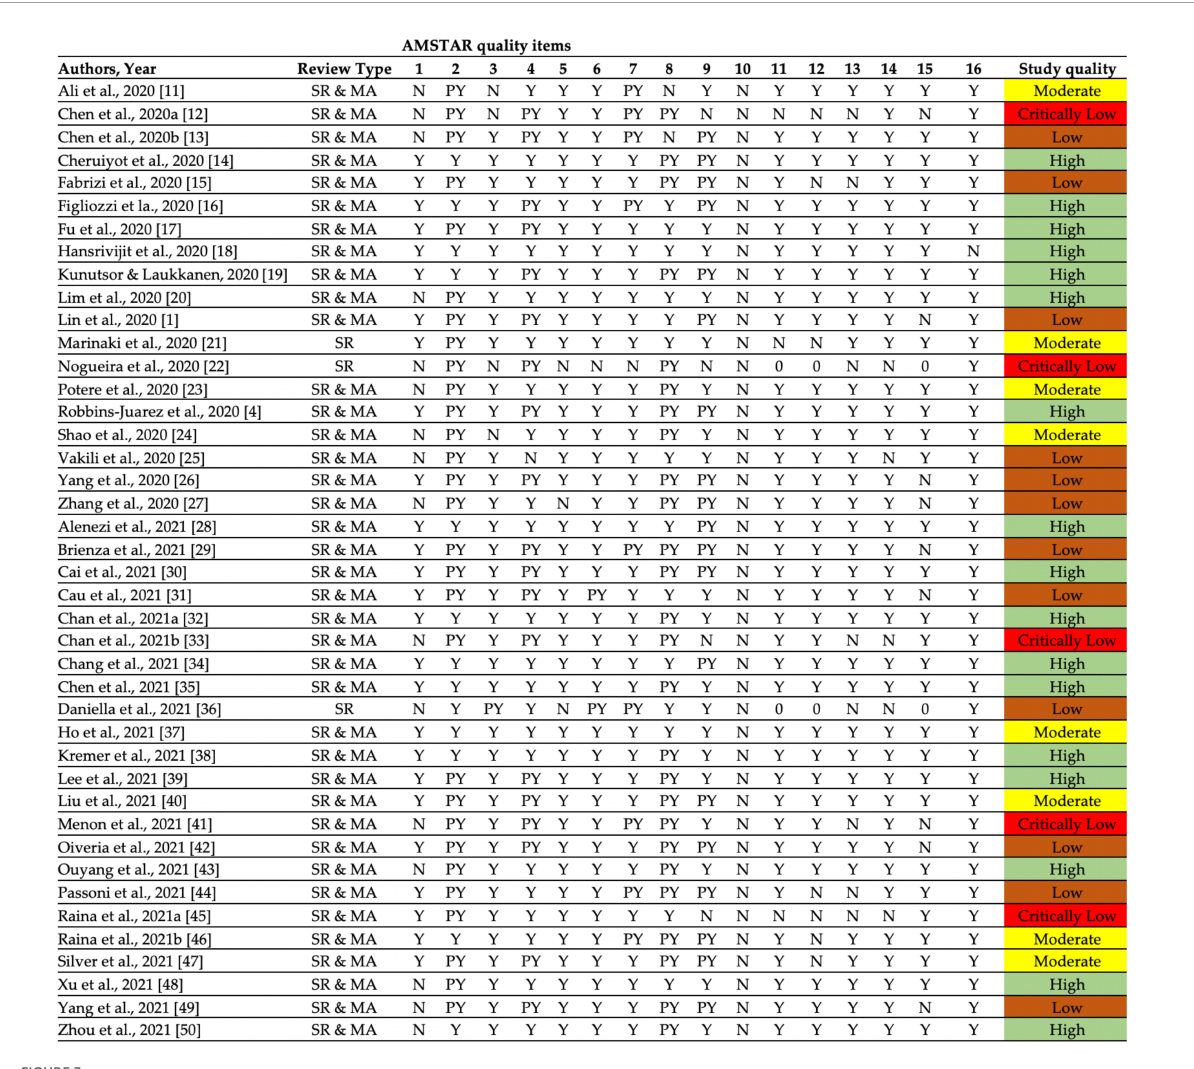
FIGURE3 Quality assessment of included systematic reviews and meta-analyses according to AMSTAR-2 checklist. (High: Zero or one non-critical weakness, Moderate: More than one non-critical weakness, Low: One critical flaw with or without non-critical weaknesses, Critically low: More than one critical flaw with or without non-critical